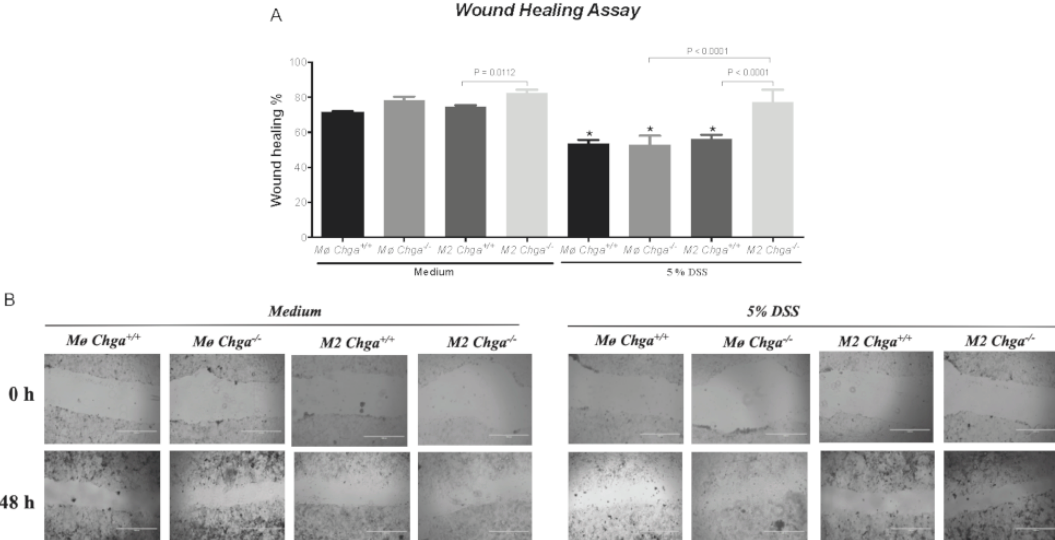
Figure 8. Chromogranin-A ( Chga )-deficient alternatively activated macrophages (M2)-conditioned supernatant maintains the functional properties of dextran sulphate sodium (DSS)-stimulated Caco-2 epithelial cells. Caco-2 cells were seeded at 3 × 10 5 cells / well onto tissue culture plates and treated with 2 mL of non-conditioned supernatant (Mo) or M2-conditioned supernatant of wild-type ( Chga +/+ ) and Chga -knockout ( Chga − / − ) for 24 h. Then cells were challenged with 5% DSS or regular medium for an additional 24 h. ( A , B ) Epithelial cell migration (wound healing assay) at magnification of 100x. One-way ANOVA followed by Tukey’s multiple comparison tests. Each value represents the mean ± SEM, n = 6. * p < 0.05 refers to significance compared with medium groups. Each experiment was repeated at least three times.